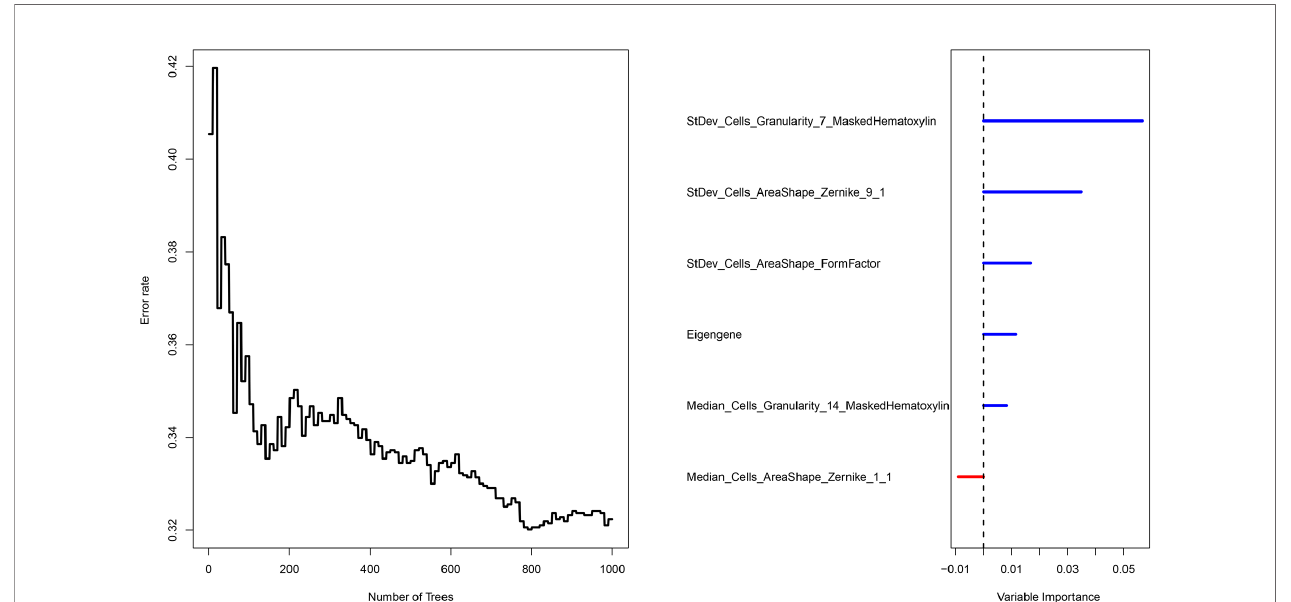
FIGURE 6 | Survival prediction of the integrated model with the prognosis-related features and genomic data using random forest.